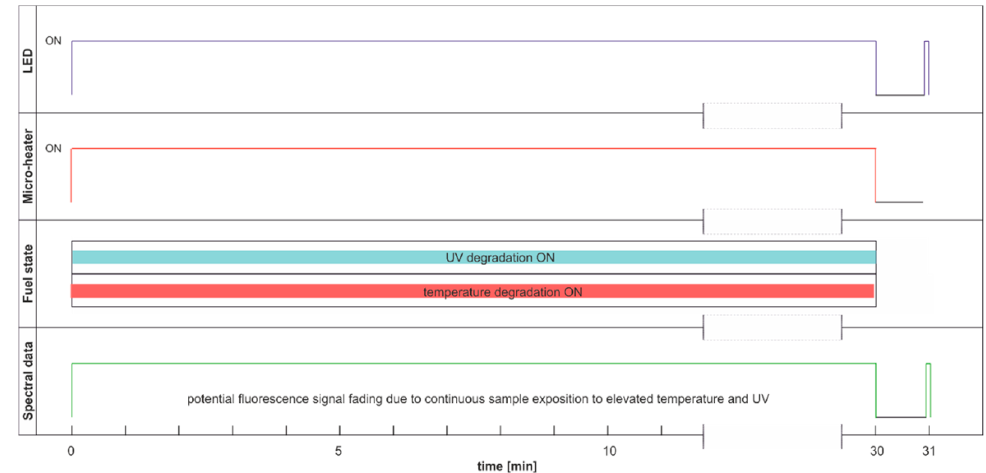
Figure 18. Degradation and examination cycle of fuel with UV and thermal radiation simultaneous use named DCE:UVonTon.